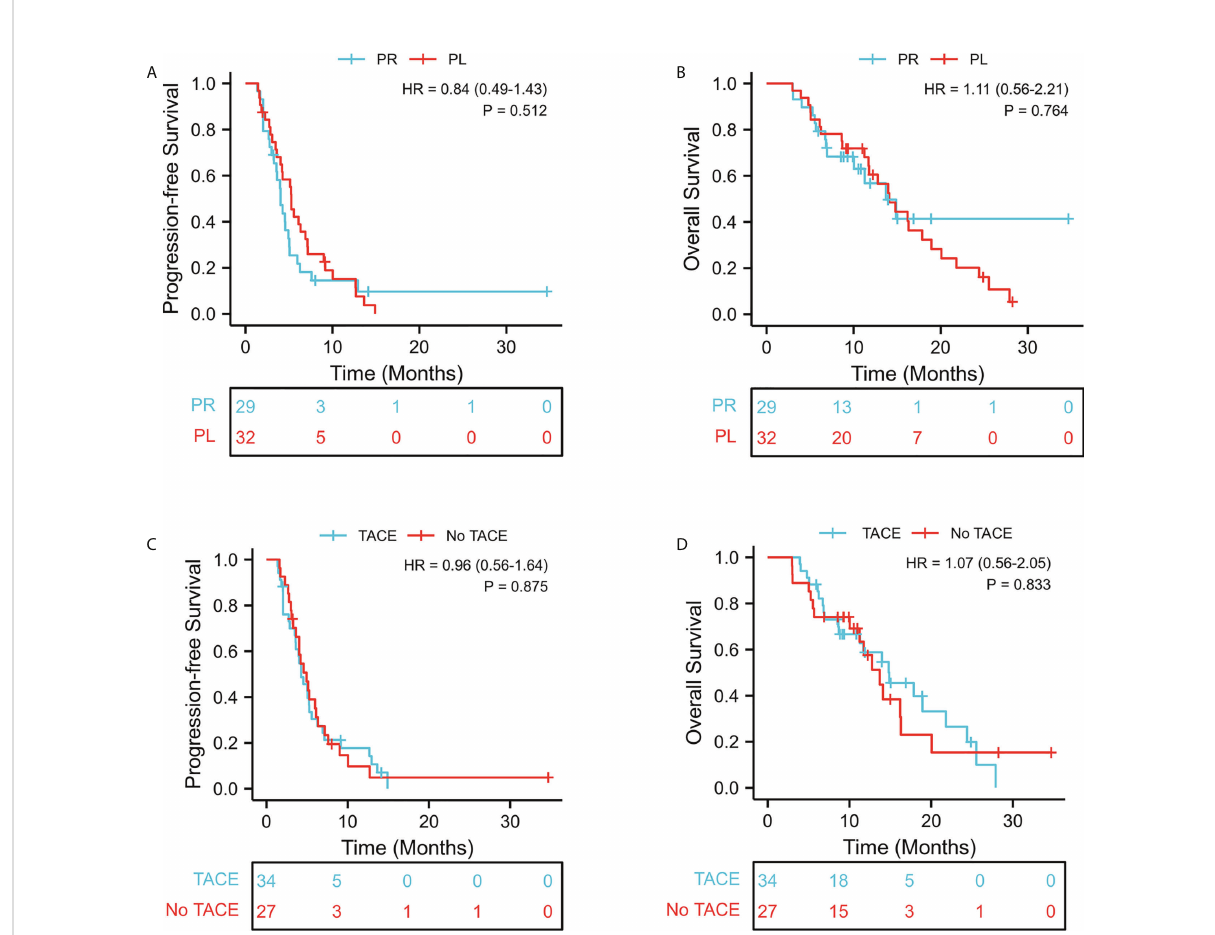
FIGURE 2 Kaplan-Meier curves of survival outcomes of patients in the two groups. (A) Progression-free survival. (B) Overall survival. Kaplan-Meier curves of survival outcomes of patients in the TACE/No TACE groups. (C) Progression-free survival. (D) Overall